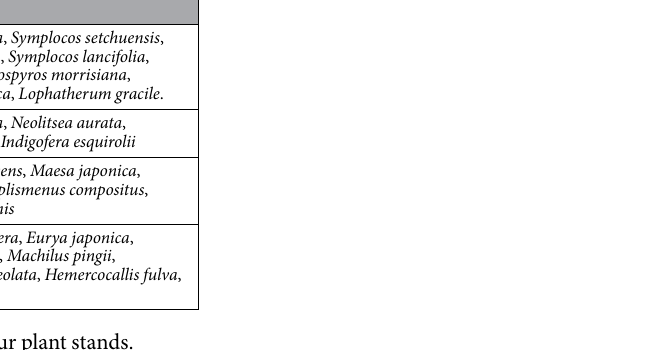
Table 4. Major components of four plant